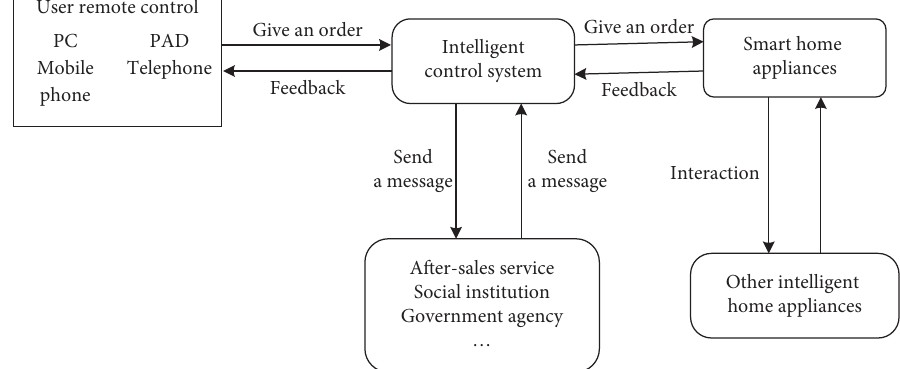
Figure 1: Diagram of smart home appliance and its